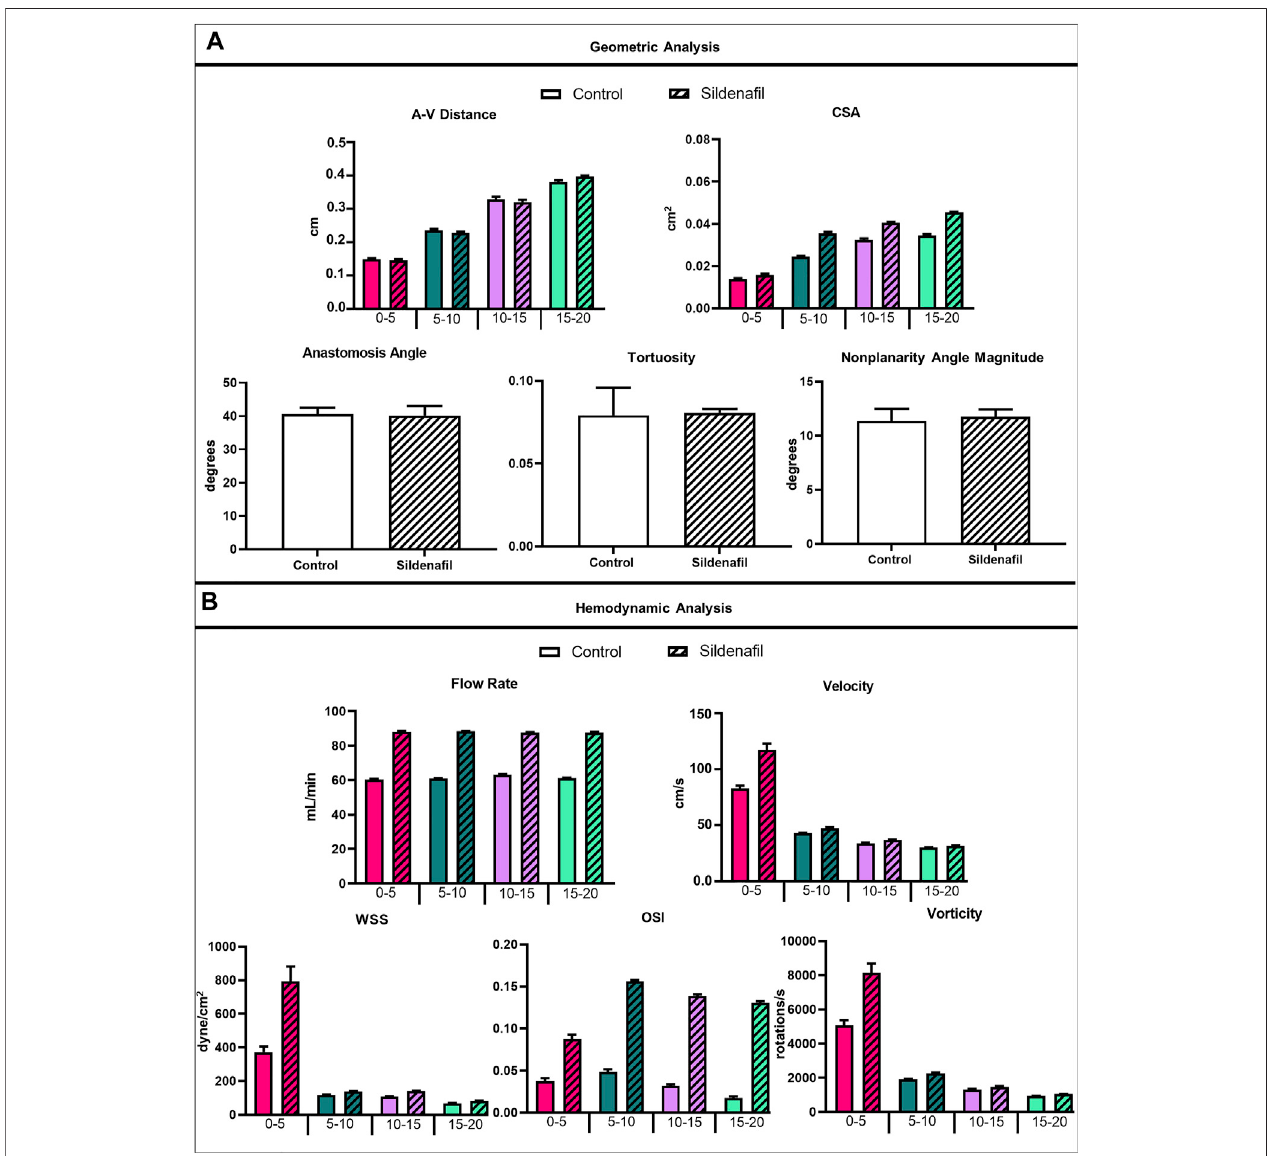
FIGURE 4 | Geometrical and hemodynamic results. (A) Geometric analysis results for A-V distance, CSA, anastomosis angle, tortuosity, and nonplanarity angle magnitude. (B) Hemodynamicanalysisresultsfor fl owrate,velocity,WSS,OSI,andvorticity.Dataexpressedasmean ± SEM.Statisticalsigni fi cancenotshownherebut described in text. N (cid:2) 4 for each